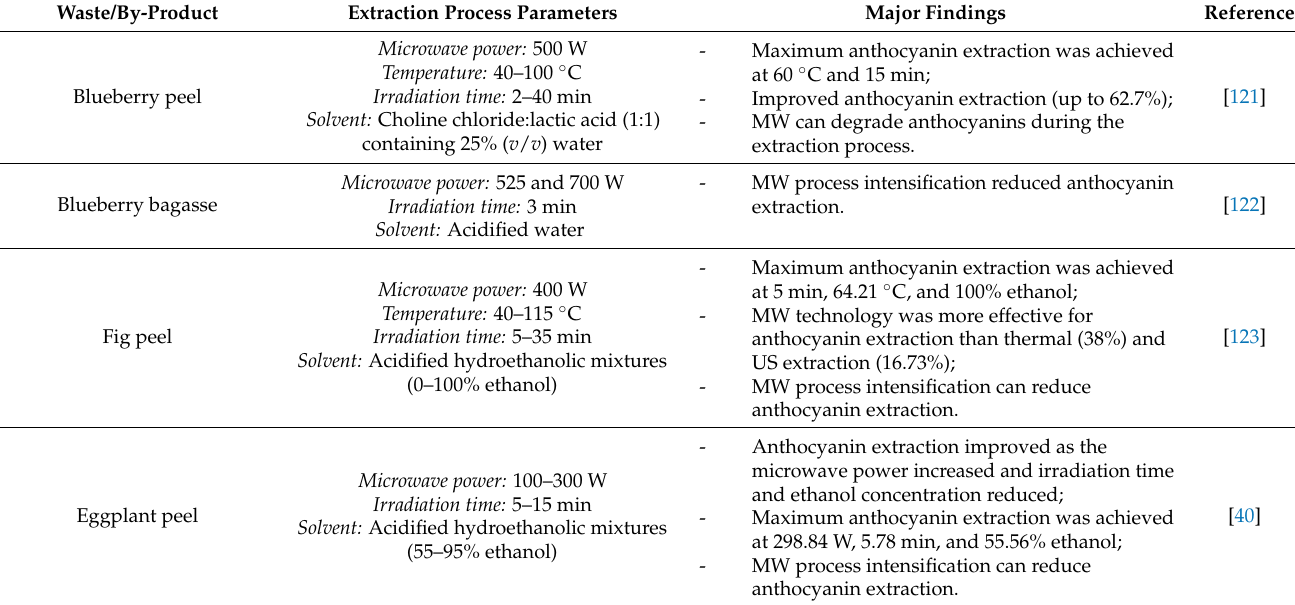
Table 3. Summary of the main recent findings showing the effects of the microwave (MW) technology on anthocyanin extraction from agri-food